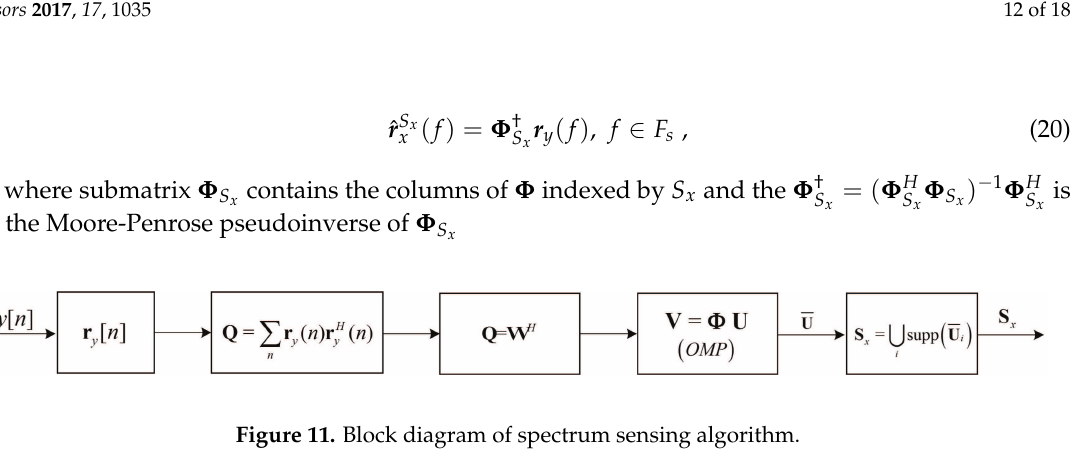
Figure 11. Block diagram of spectrum sensing algorithm.